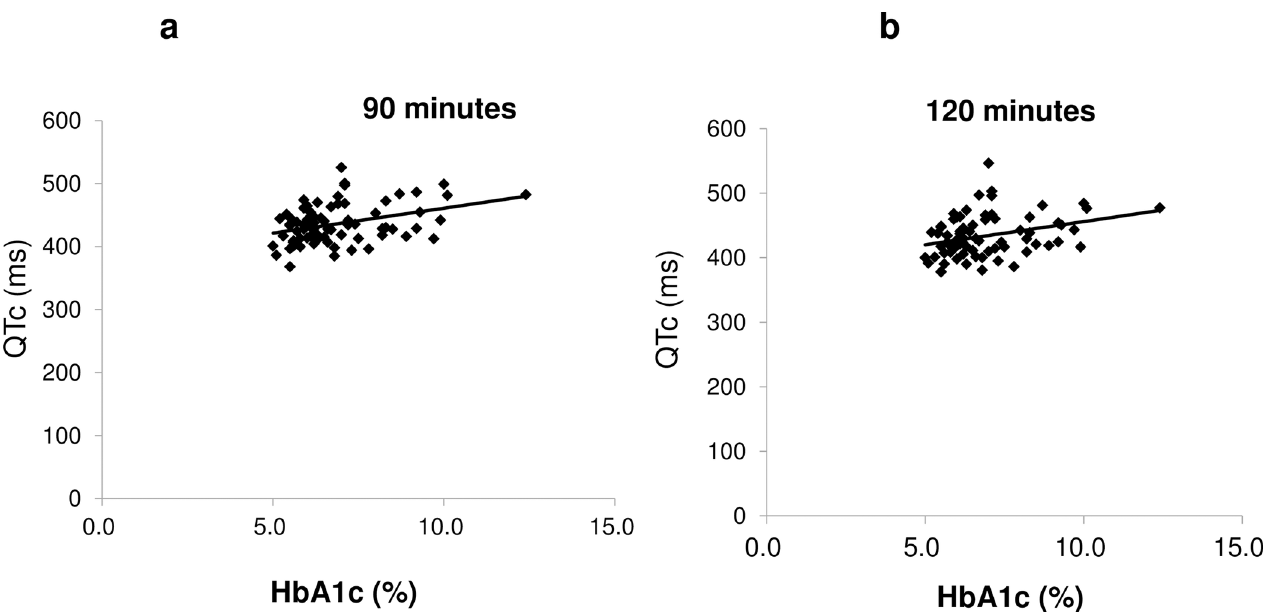
Fig 3. 3A and 3B. Correlation between the QTc intervals and HbA1c levels at 90 min (Fig 3A) or 120 min (Fig 3B) after sevoflurane administration. 3a. The QTc intervals(Y-axis) recordedat 90 min after the administration of sevoflurane are plotted againstHbA1c% values (X- axis). The formula for the regressionline was Y = 7.910 X + 381.8 (solid line), and the coefficient ofdetermination (r2) was 0.1354(P = 0.001). 3b. The QTc intervals (Y-axis) recorded at 120 min after the administration of sevoflurane are plotted against HbA1c%values (X-axis). The formula for the regression line was Y = 7.191X + 384.0 (solid line), and the coefficient of determination (r2) was 0.1013 (P = 0.006).